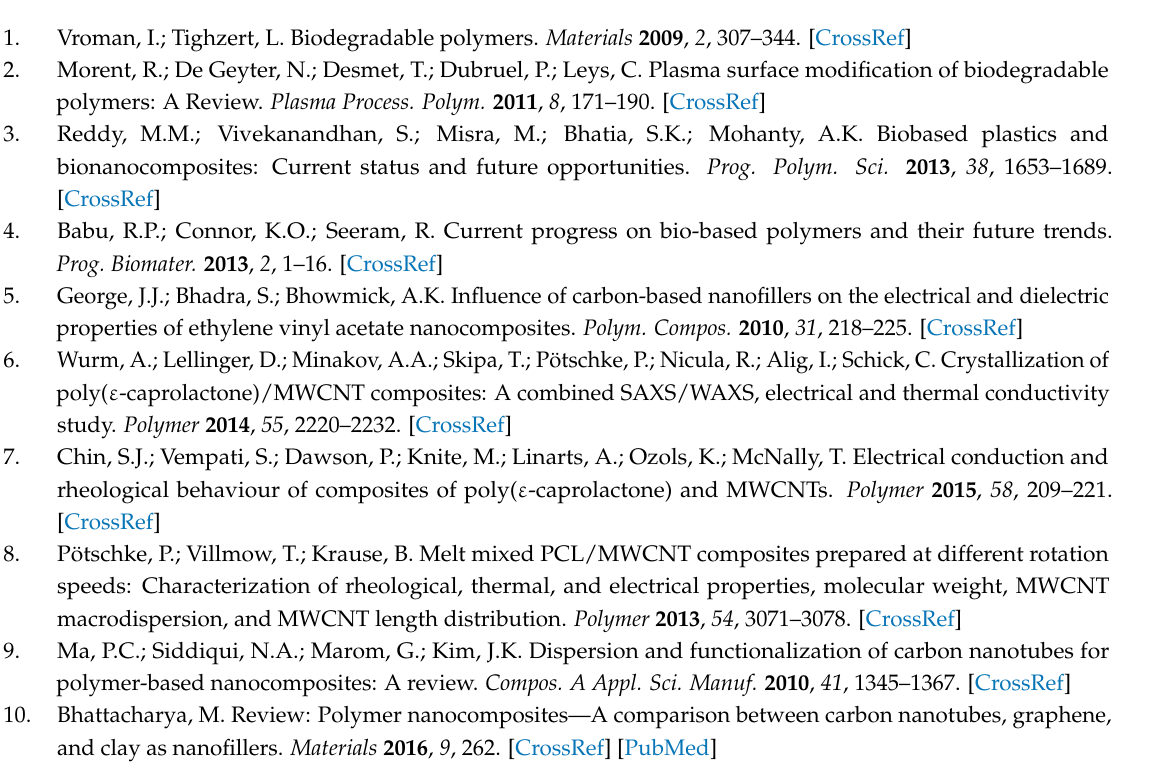
Figure S1: Heating of PCL after isothermal crystallization at 41 ◦ C, Table S1: Kinetic parameters for all the investigated samples during isothermal